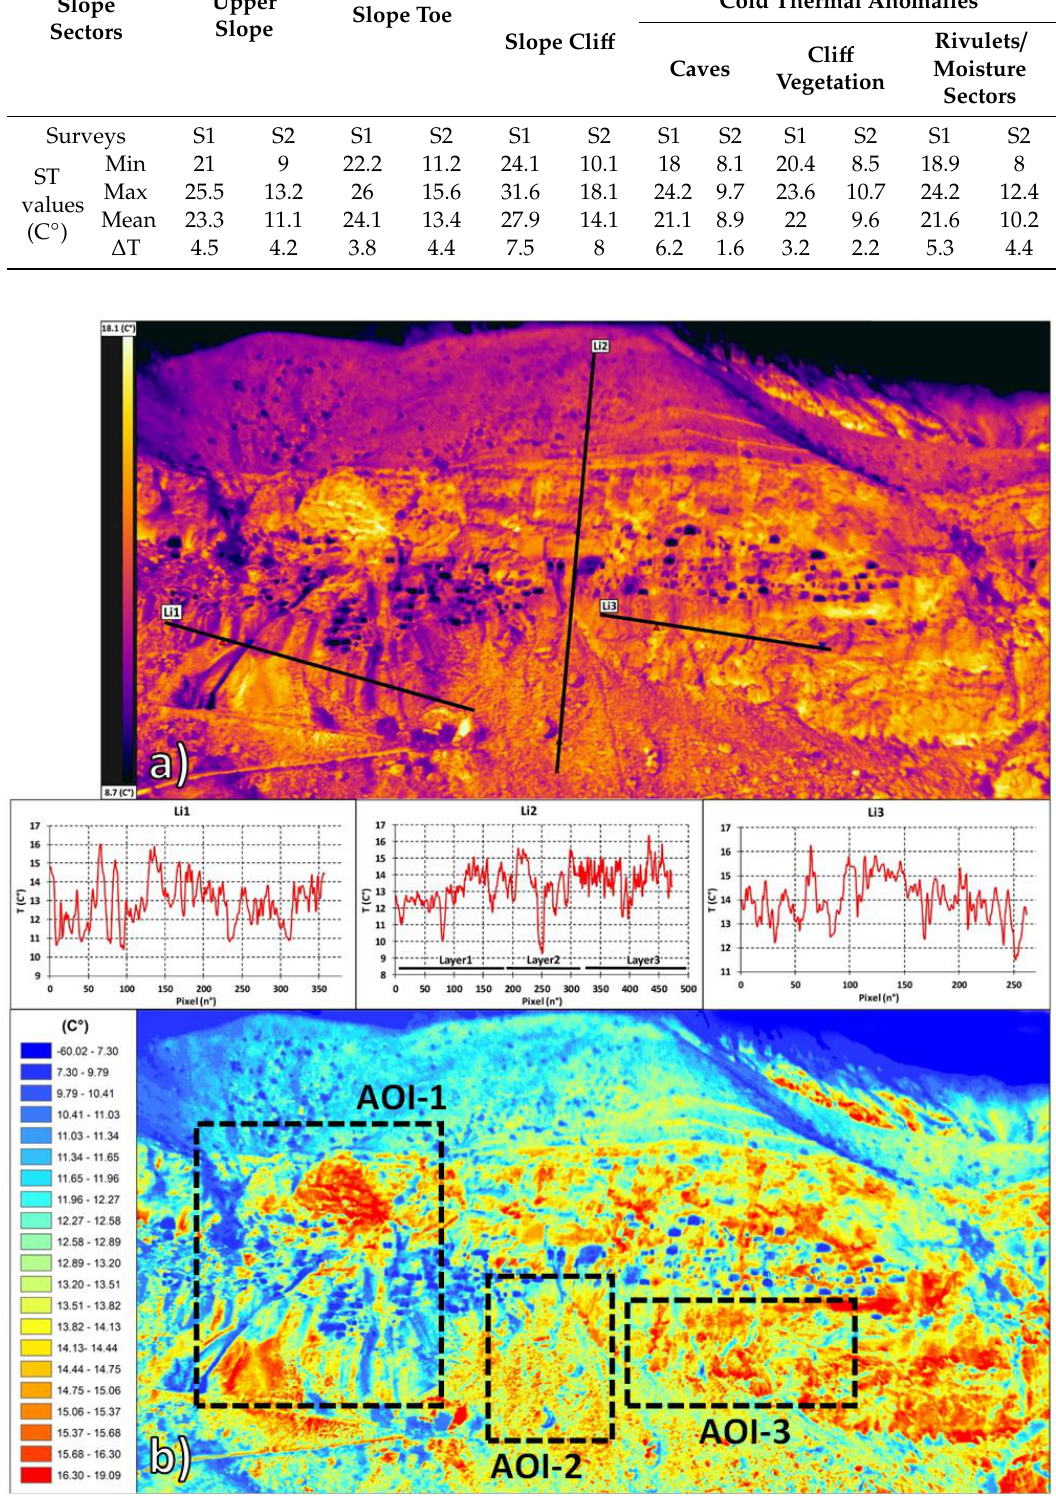
Figure 9. IRT data acquired in S2: ( a ) Mosaicked thermograms acquired on November 20th at 18:40, including ST profiles Li1-3, ( b ) corresponding classified image. Corresponding visible image ( c